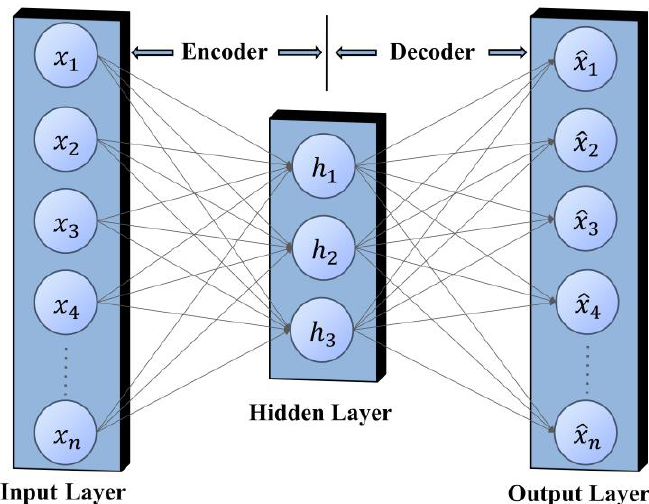
Figure 5. Autoencoder